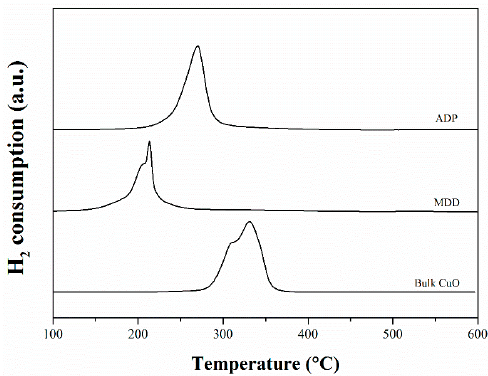
Figure 4. H 2 ‐ TPR (temperature programmed reduction) profile of the CuO/SBA ‐ 15 materials prepared by ADP (top) and MDD (middle) methods and the bulk CuO (bottom).